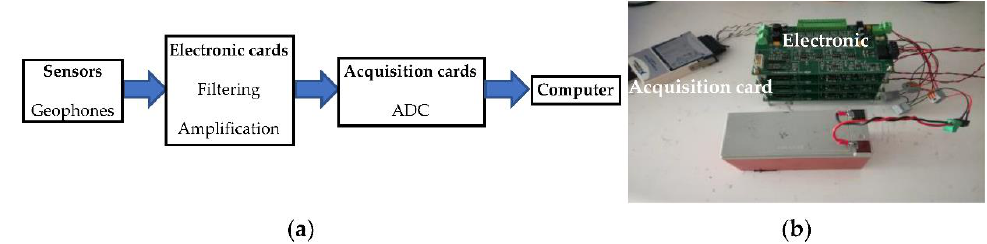
Figure 11. Experimental set-up of the reception chain: ( a ) scheme of the main components; ( b )